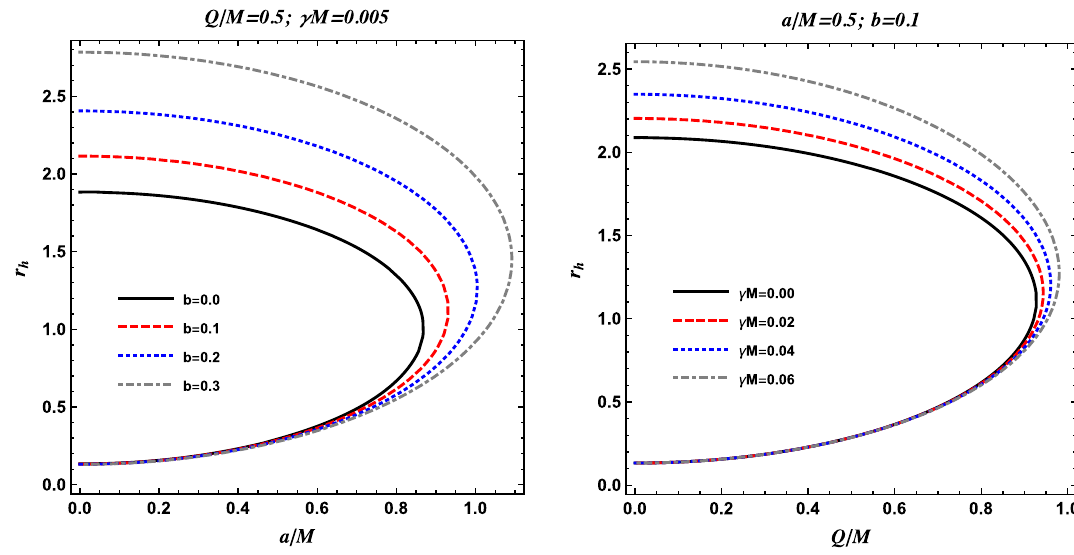
Fig. 1 The plots show the horizons structure of the KNKL black hole for different values of the